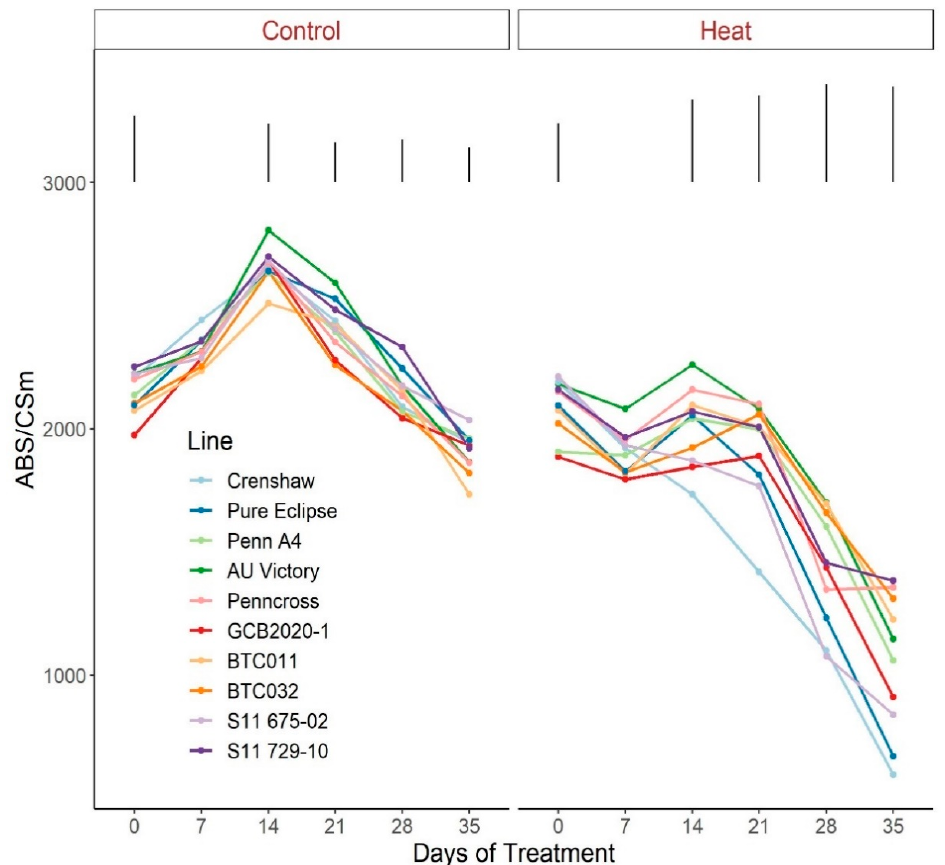
Figure 7. Change of ABS/CSm for creeping bentgrass lines over time under control (20/15 ◦ C day/night) and heat stress (38/33 ◦ C day/night) conditions. Bars represent LSD values at p = 0.05 on days when significant differences mong lines were found.